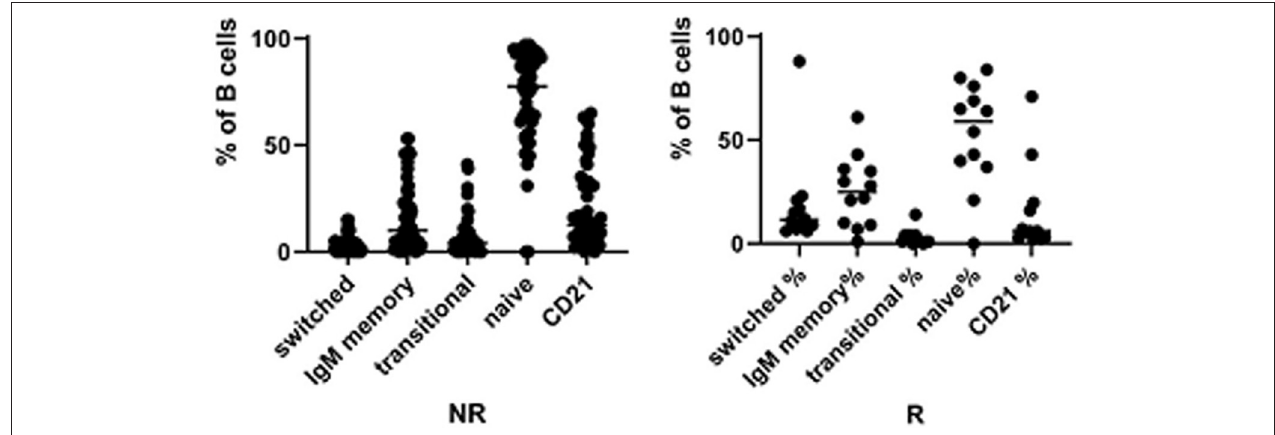
FIGURE 2 | Frequencies of switched memory B cell, IgM memory B cells, Transitional B cells, naïve B cells and CD21low B cells in CVID IgA NR and CVID IgA R.